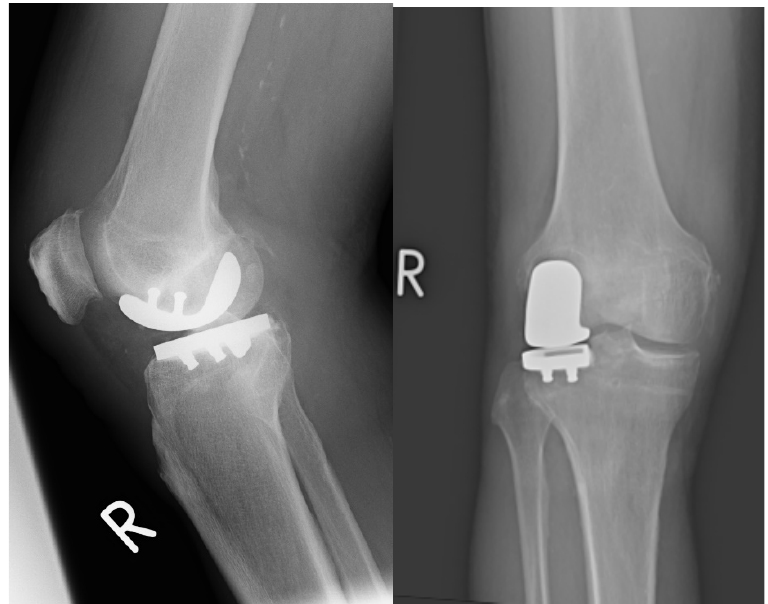
Figure 5. Postoperative X-ray of a patient-speci fi c lateral unicondylar knee